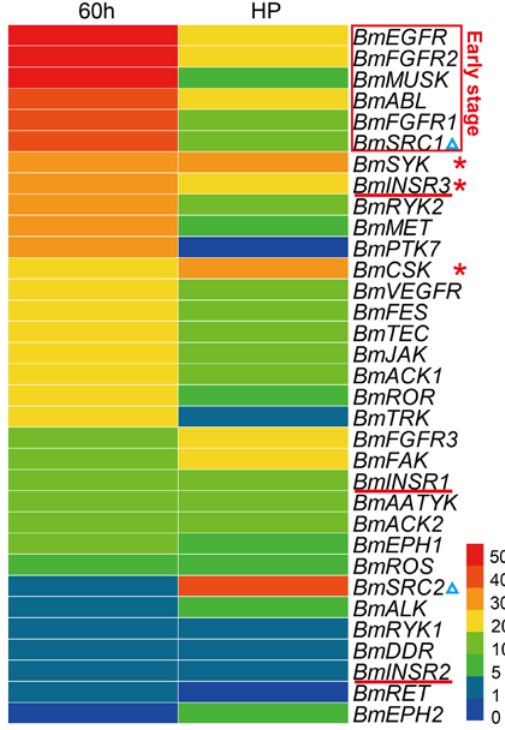
Figure 5. Gene expression profiling of BmTK genes in the embryonic period. RPKM (reads per kilo-base per million mapped reads) of digital gene expression data was used to quantify gene expression. 60 h: embryos hatching for ~60 h (early embryos), HP: embryos at head pigmentation stage (late embryos). Red box indicates the genes with high expression in the early embryos. Red asterisks indicate the genes with relatively high expression in both the early and late embryos. Blue triangles indicate the genes in the SRC subfamily. Red lines indicate the genes in the INSR subfamily.